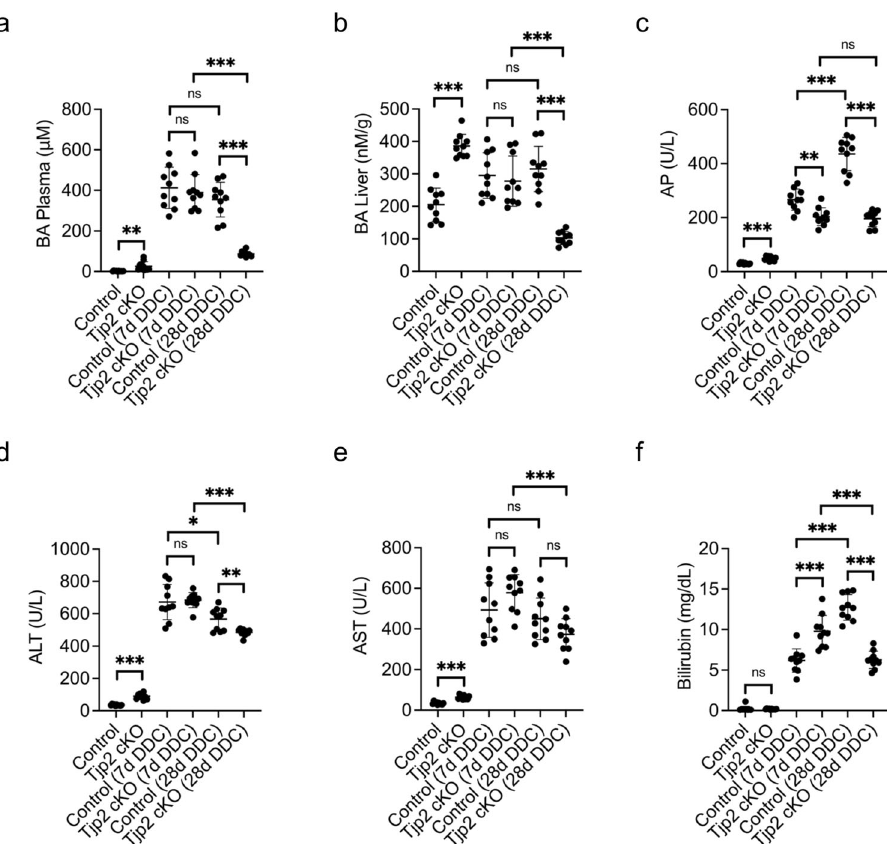
Fig. 2 Hepatic deletion of Tjp2 suppresses DDC-diet-induced liver injury. Biochemical analysis of liver and plasma markers for control and Tjp2 cKO mice fed DDC diet for 7 and 28 days. a Plasma BA, ( b ) liver BA, ( c ) AP, ( d ) ALT, ( e ) AST, ( f ) Bilirubin. Data shown as mean ± SD, unpaired Student ’ s t test. * p < 0.05; ** p < 0.005, *** p < 0.0005, ns — not signi fi cant ( p > 0.05), with p < 0.05 considered a signi fi cant difference. n = 10 mice per